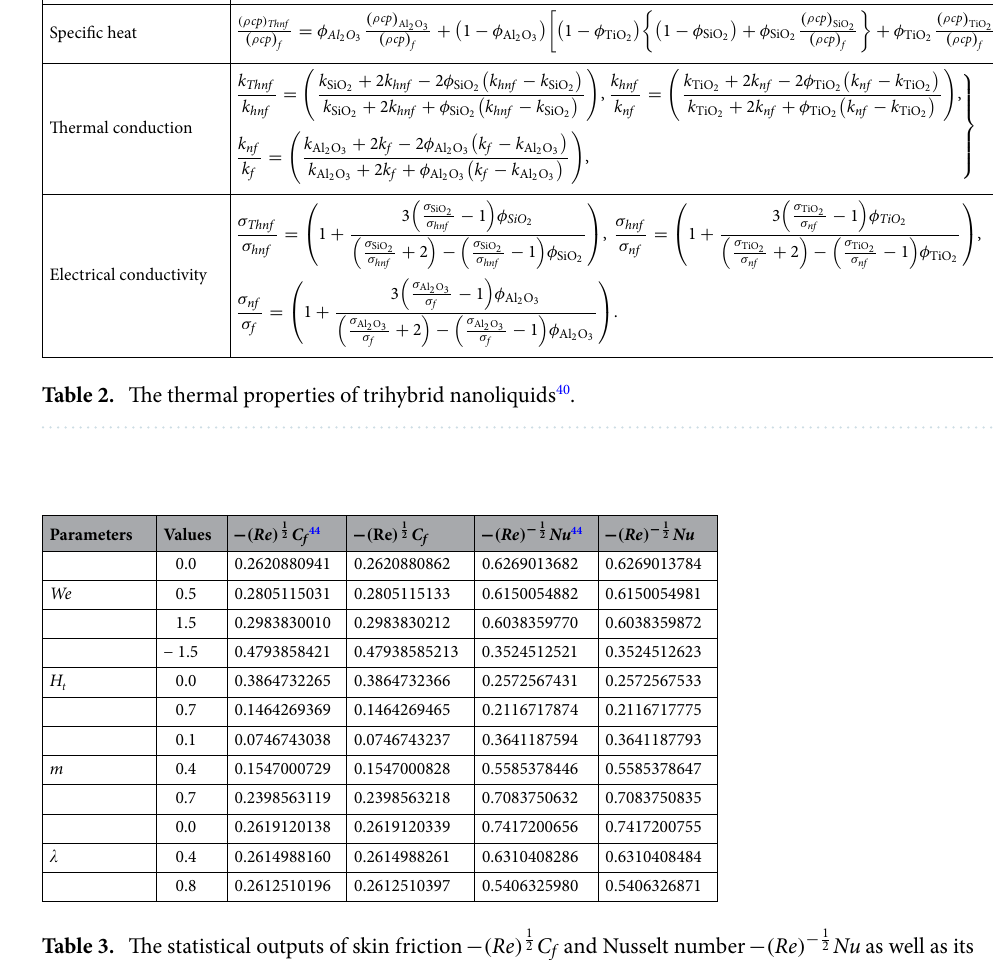
Table 3. The statistical outputs of skin friction comparison with the existing